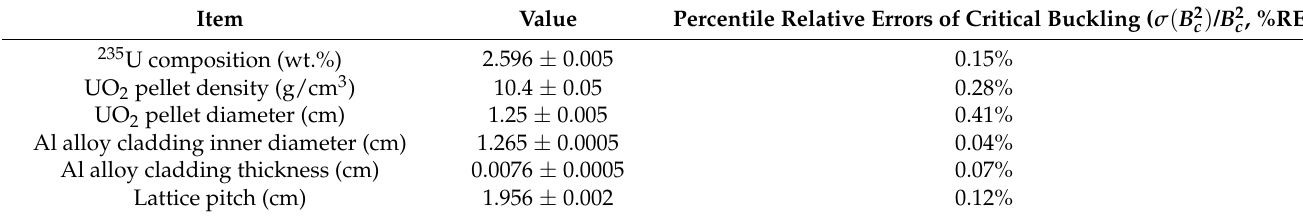
Table 7. Uncertainties of critical buckling based on geometric and material data uncertainties.